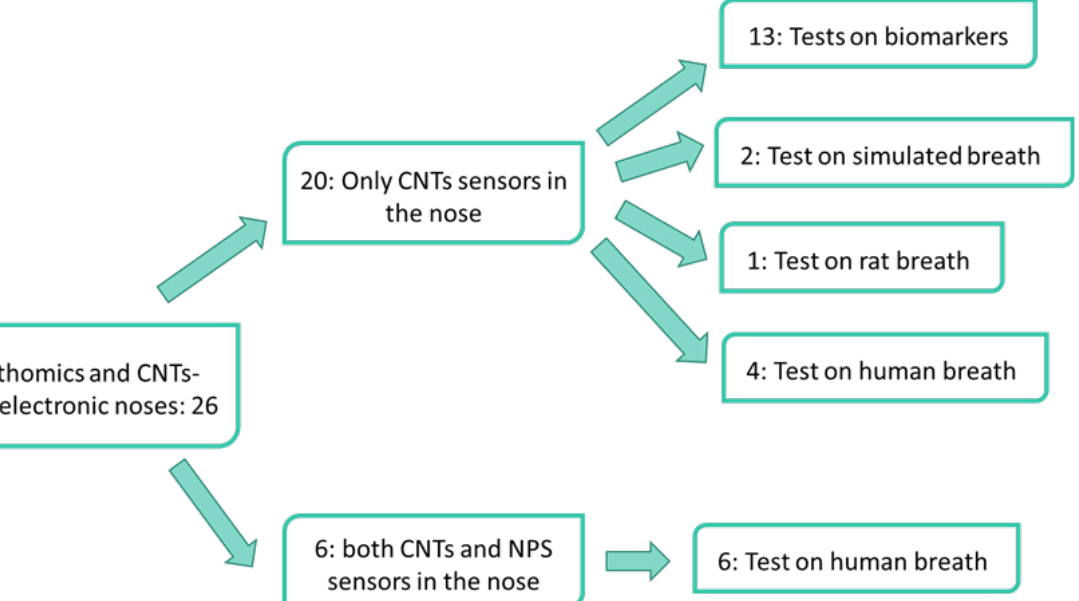
Figure 3. Flow diagram summarizing the structure of the present review. A total of 26 papers have been considered, 20 of them based on electronic noses featuring only CNTs sensors, whereas 6 papers reported on arrays based on CNTs and NPs sensors. A second classification is given by the type of analytes the papers are focused on: biomarkers, simulated breath, animal breath, or human breath.